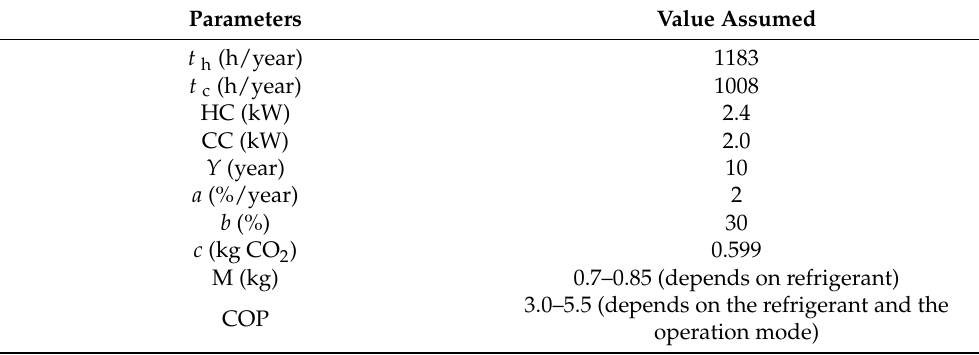
Table 6. Operation condition considered for the TEWI